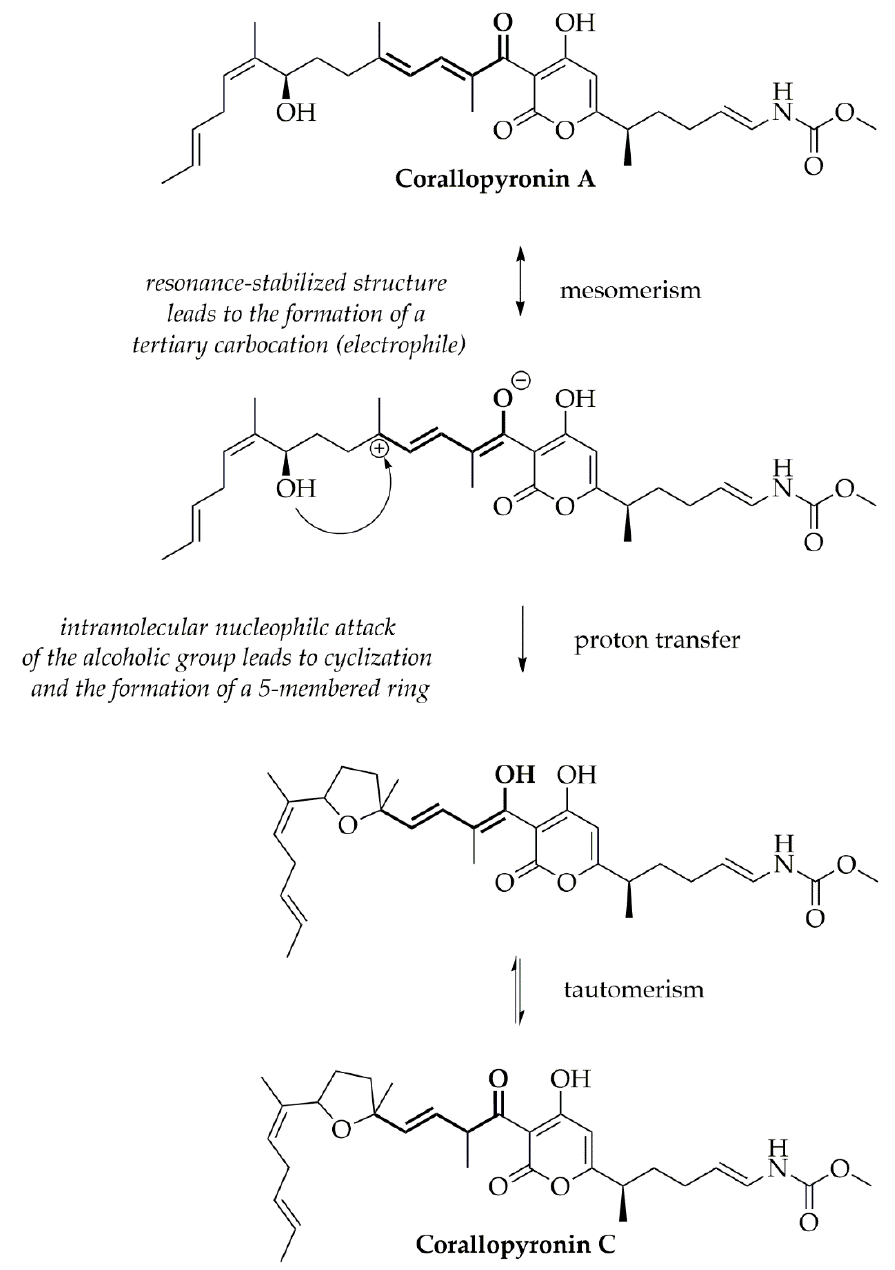
Figure 9. Postulated isomerization of CorA to CorC due to an intramolecular nucleophilic attack of the alcoholic group.